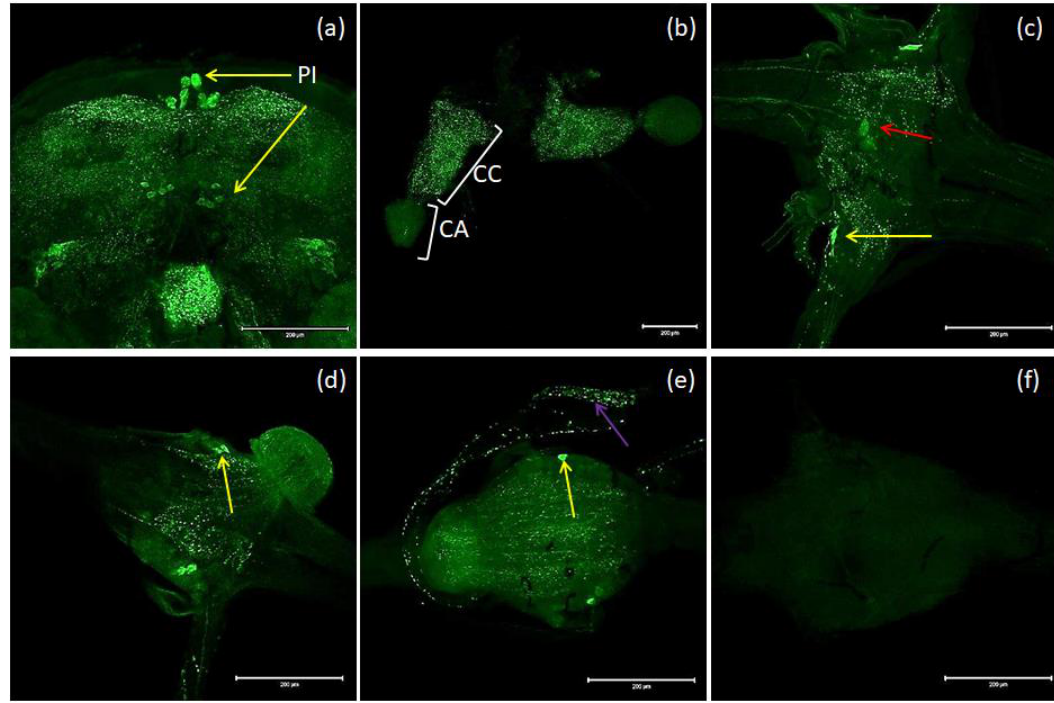
Figure 3. Examples of images from confocal microscopy depicting the location of MIP / AST-reactive neurons in the brain ( a ) and CC / CA ( b ) of adults as well as the VNCs of the larvae ( c ), pupae ( d ) and adults ( e ) of T. molitor beetles using antibodies against Drome-MIP. Control image ( f ). The selected scale is 200 µ m. The yellow arrows indicate nerve cell bodies, red arrow–perisympathetic organ (PSO) and violet arrow—varicosities in axonal transport. PI— pars intercerebralis , CC / CA— corpus cardiacum / corpus allatum , VNC—ventral nerve cord.